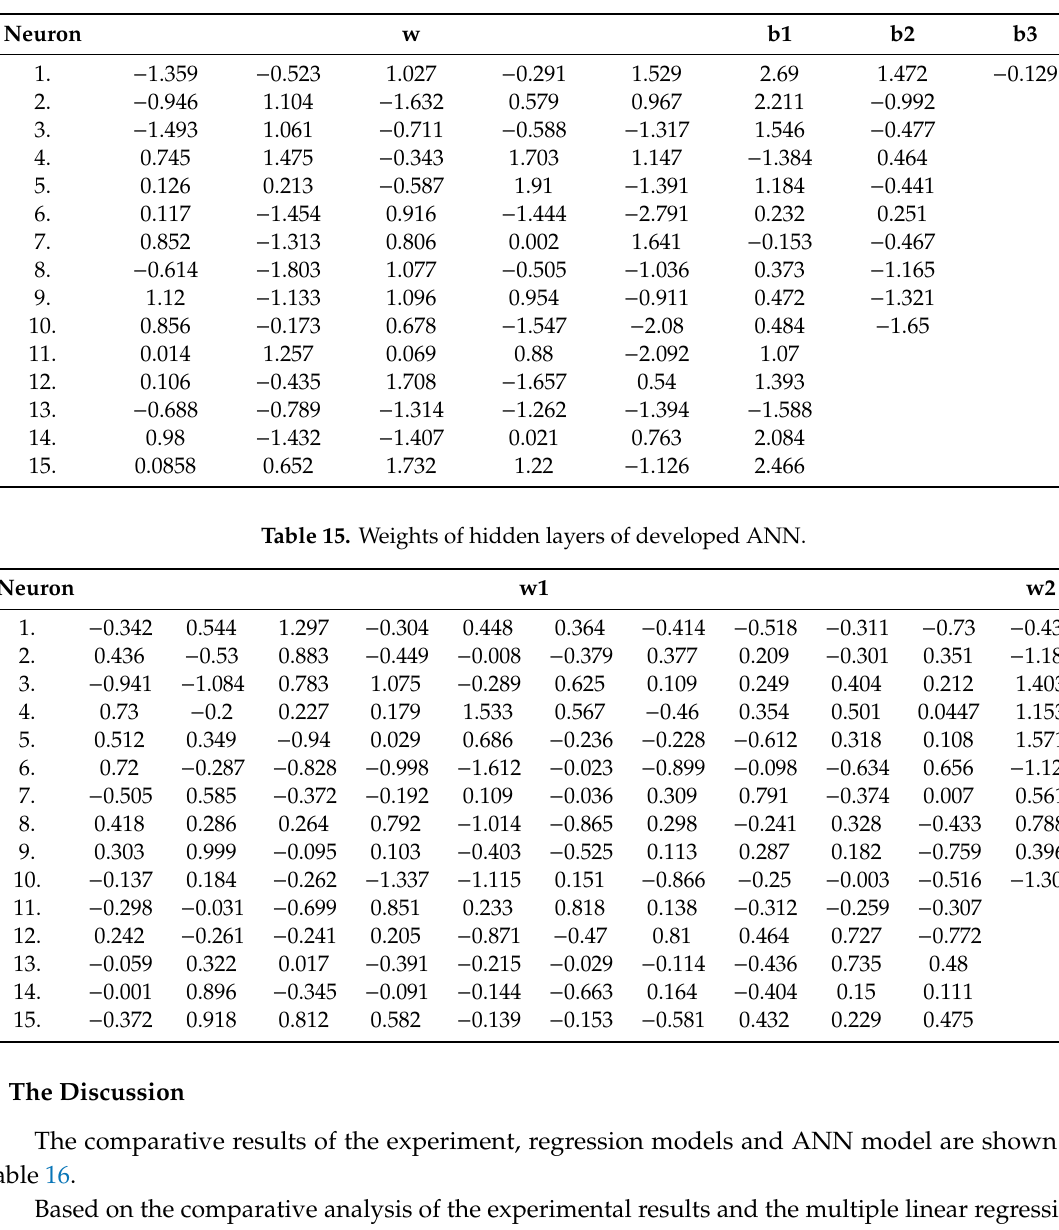
Table 14. Weights between inputs and hidden layer and biases of developed ANN.